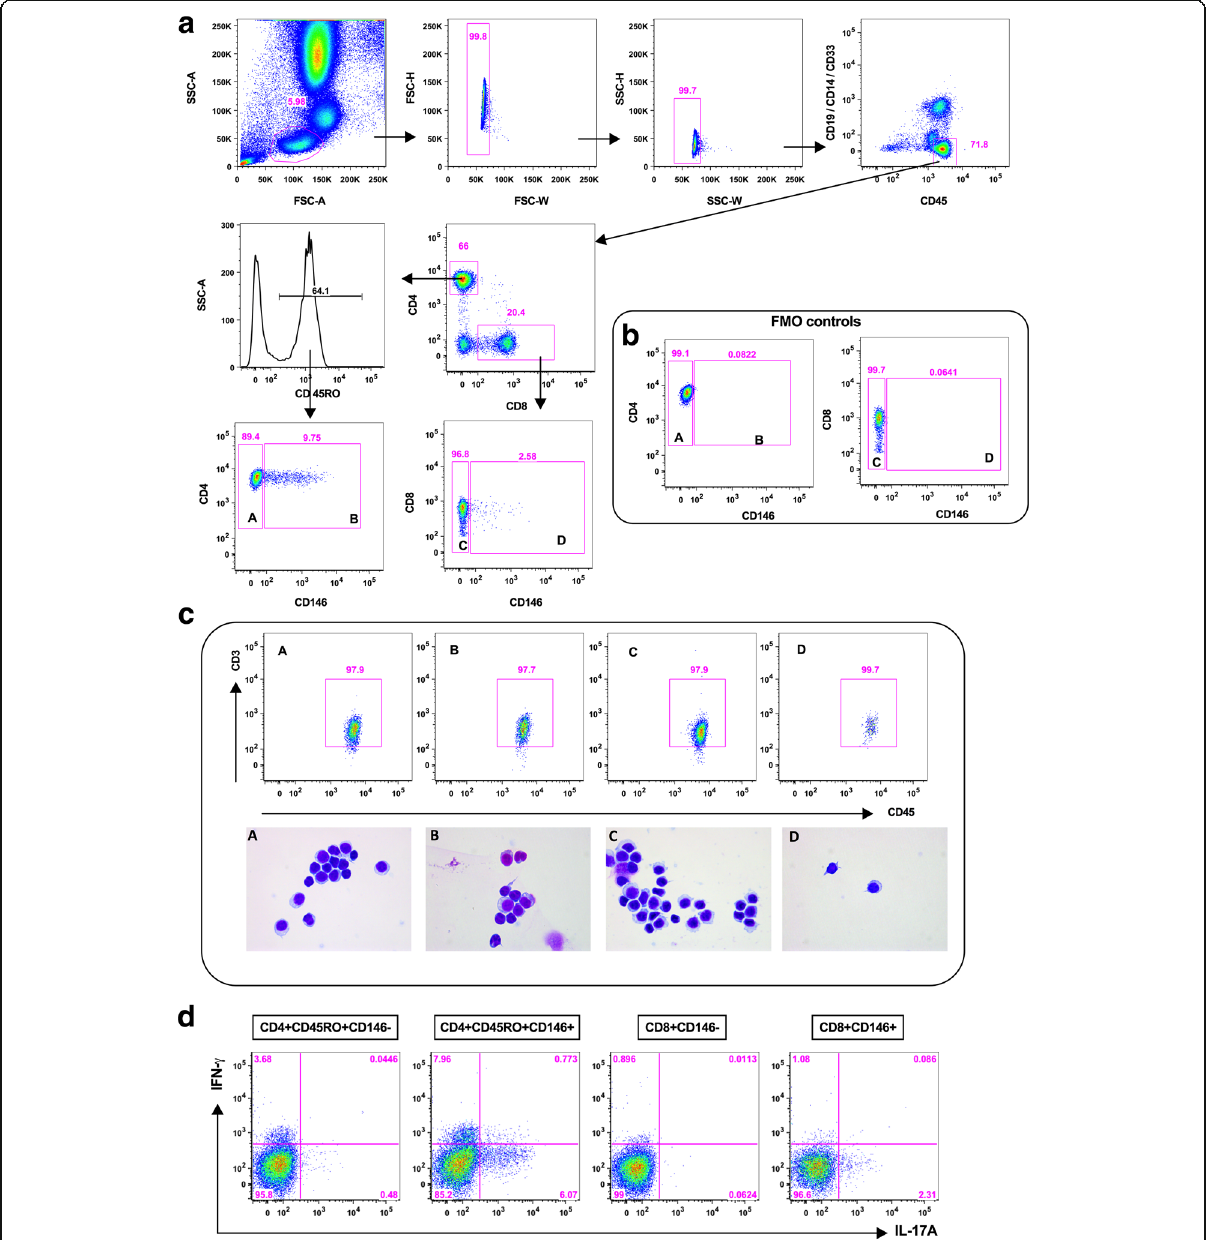
Fig. 1 Schematic representation of FACS plots showing strategy for sorting CD146+ Th17 and Tc17 cells. a Cells obtained after whole blood lysis were stained and sorted as CD45+CD19-CD33-CD14-CD4+CD45RO+CD146- (Th17 negative subset), CD45+CD19-CD33-CD14-CD4+CD45RO+CD146+ (Th17 positive subset), CD45+CD19-CD33-CD14-CD8+CD146- (Tc17 negative subset), and CD45+CD19-CD33-CD14-CD8+CD146+ (Tc17 positive subset). Lymphocytes were gated on forward and side scatter and doublets were removed. On gated CD45+ cells CD45RO+CD4+CD146+ were gated for Th17 cells and CD8+CD146+ as Tc17 cells. b Gating for CD146 was done on the basis of FMO controls. c Sorted cells were acquired to check purity and expression of CD3 antigen on sorted of populations. The cells were collected and stained with Diff-Quick cell staining kit to show lymphocyte morphology. d IL-17A and IFN-g secretion by freshly sorted Th17 and Tc17 positive and negative subset. As observed from the stimulated cells CD146+ CD4+ and CD146+ CD8+ cells were secreting IL-17A and